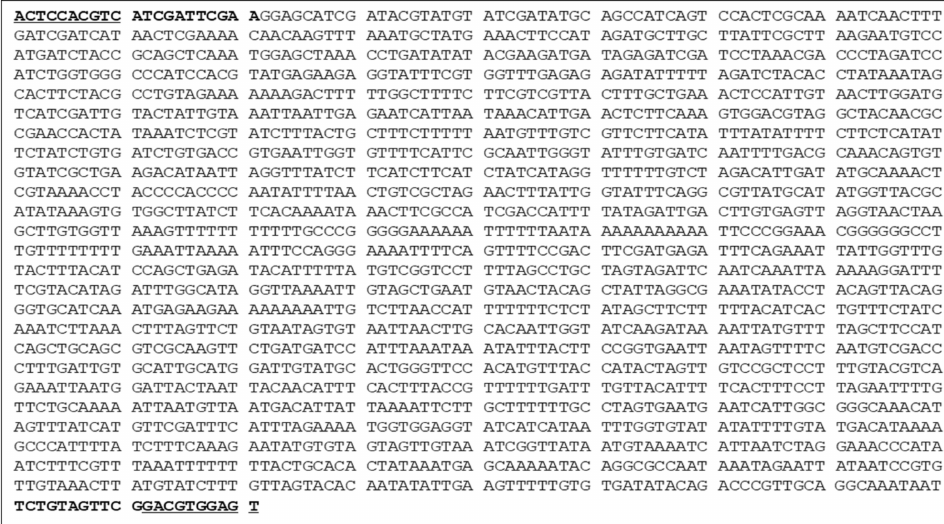
Figure 2. The SCAR-OPAN-1 primer and sequence of a 2-Kb product amplified in four resistant lines by an OPAN-1 random primer. The SCAR-OPAN-1 primer contained the OPAN-1 random primer sequence. The sequence of the designed SCAR-OPAN-1 primer is shown in bold. The underlined sequence is the sequence of OPAN-1 random primer, 5 (cid:48) -ACT CCA CGT C-3 (cid:48)